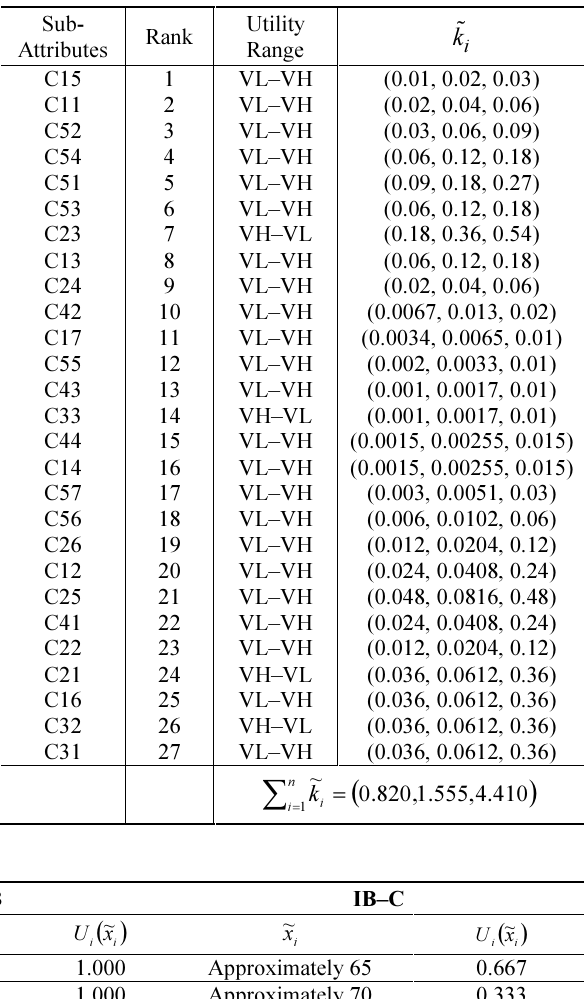
Table 3. The fuzzy scaling factor values and ranking of the